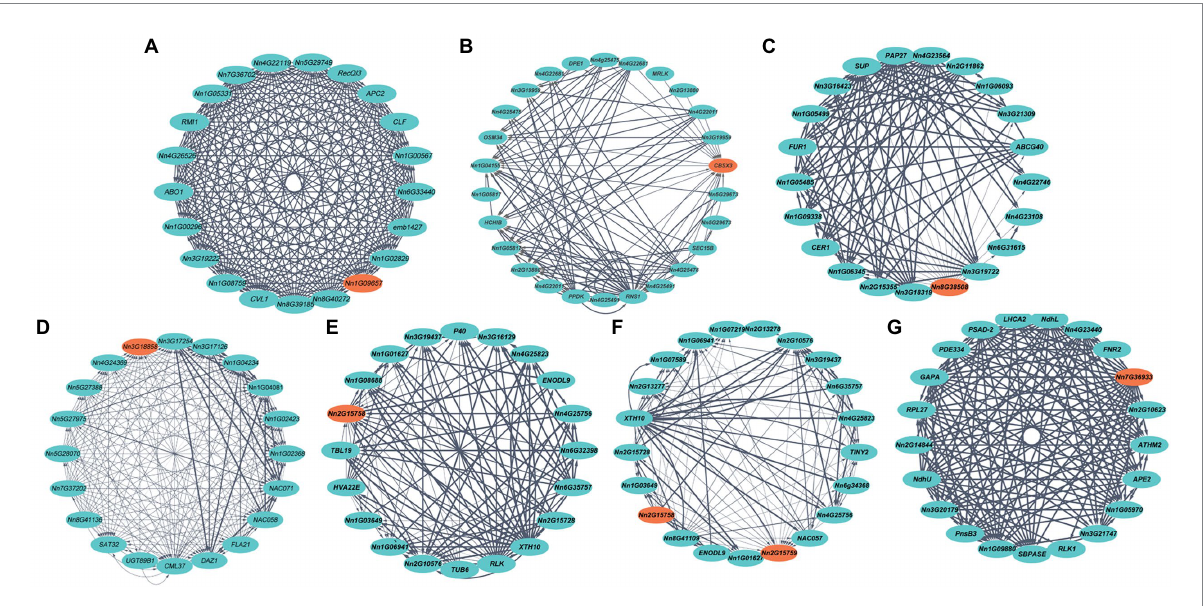
FIGURE 5 Inference of candidate gene functions by coexpression network analysis. Orange nodes denote trait-related candidate genes in our study. (A-C) Genes associated with flower diameter. (D) Genes associated with the maximum petal length. (E,F) Genes associated with the maximum petal width (cm). (G) Genes associated with plant size. Blue nodes are genes that are coexpressed with the candidate genes. The edge width denotes the interaction intensity between